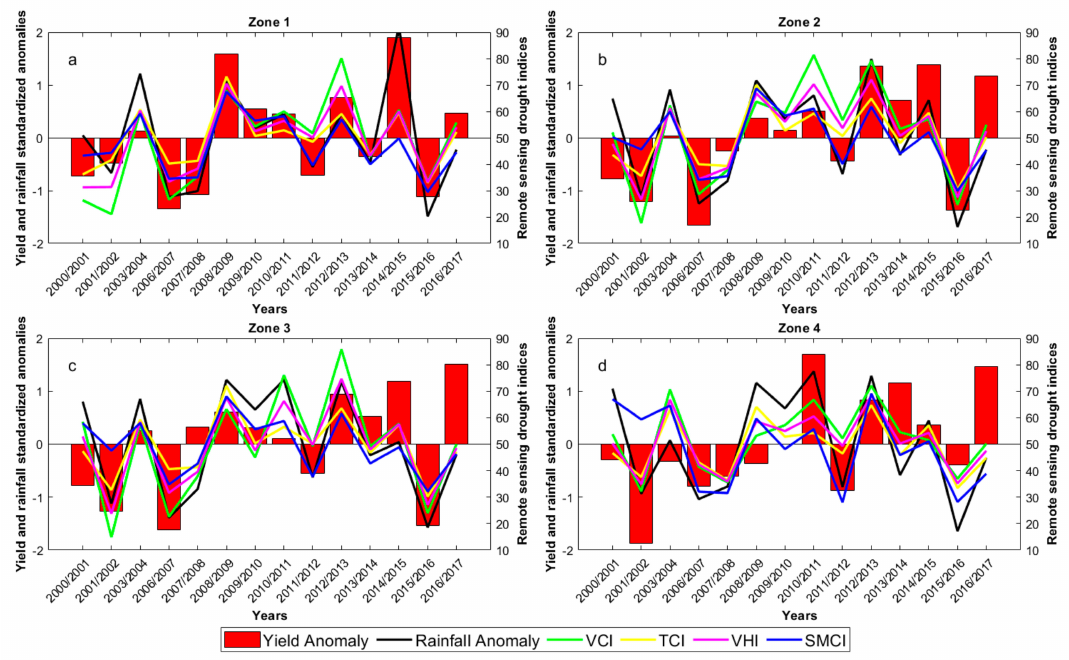
Figure A4. Monthly evolution of the remote sensing drought index anomalies VCI, TCI, VHI, SMCI, SWI60, and LDAS output standardized anomalies LAI, Tr, WG2 (0–4 cm), WG6 (40–60 cm) and SPEI3 for zone 1 ( a ), zone 2 ( b ), zone 3 ( c ) and zone 4 ( d )during the 2011 / 2012 dry crop